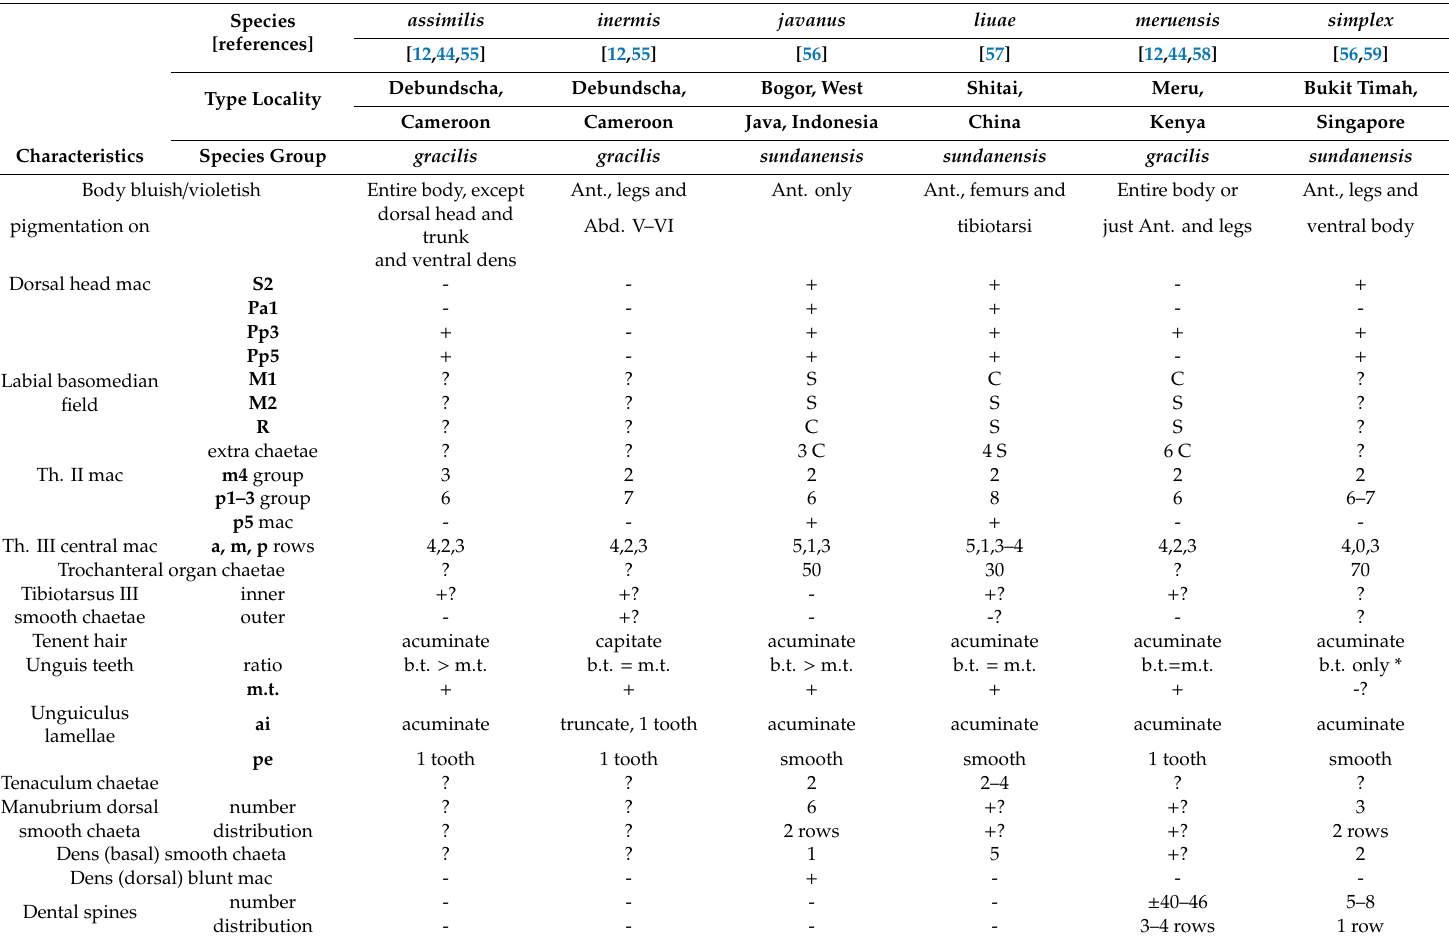
Table 5. Comparison among Dicranocentrus species from the Old Word with Abd I–III with 3, 2 and 1 central mac,